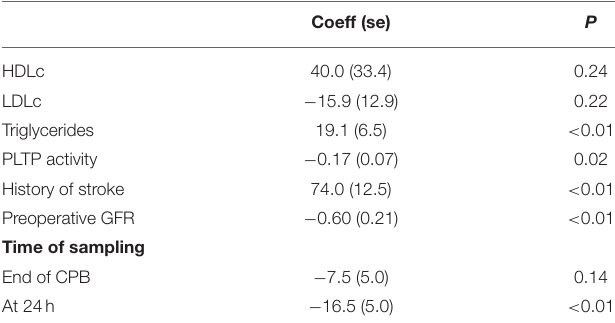
TABLE 2 | Variables associated with perioperative lipopolysaccharide concentrations in multivariate analysis.